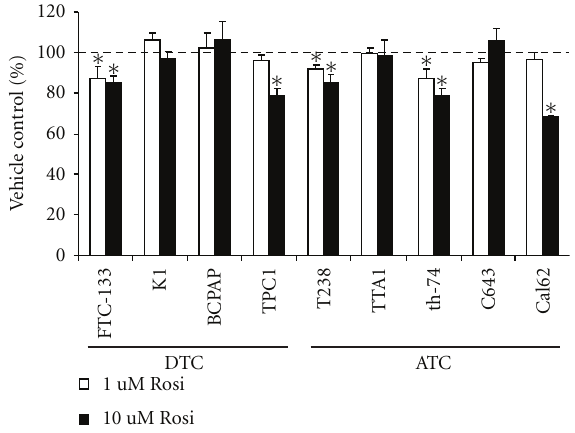
Figure 1: E ff ect of a PPAR γ agonist on in vitro growth of thyroid cancer cell lines. Cells (denoted on the x -axis) were treated with vehicle (DMSO), or Rosi (1 μ M or 10 μ M) every 3 days for 6 days. The e ff ect of treatment on proliferation was determined by automated viable cell counting. Data is represented as percent viable cells/mL compared to vehicle, which is denoted by the dashed line. Mean ± S.E.M. of at least 3 independent experiments performed in duplicate is reported ( ∗ , P < 0 . 05 when compared to vehicle